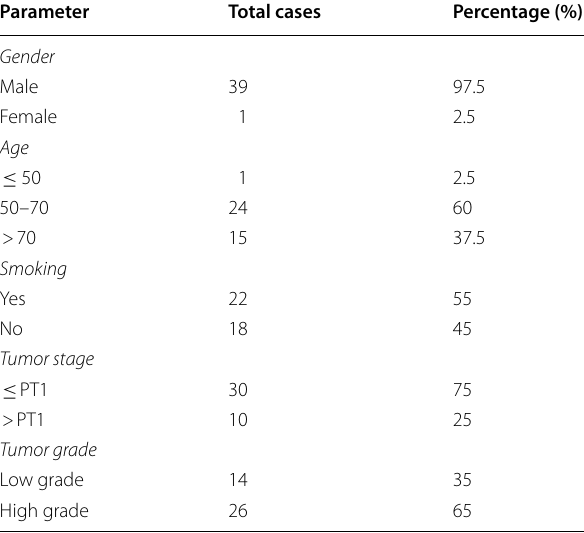
Table 2 Tumor characteristics of recruited cases Parameter